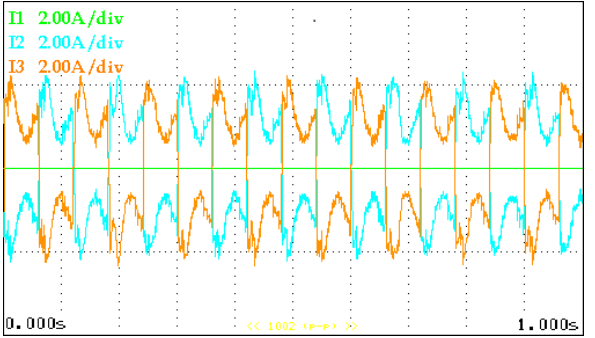
Figure 13. Currents in the BLDC motor operating under phase fault condition without current reduction strategy.